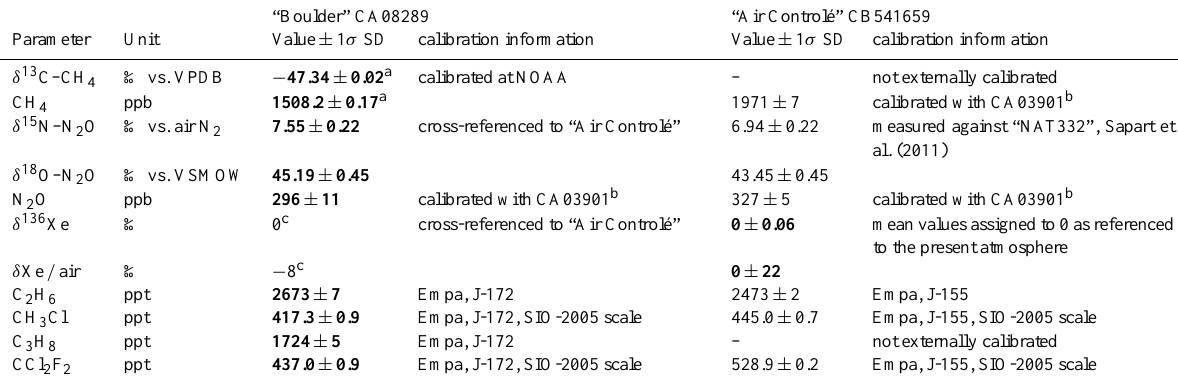
Table 2. List of assigned values for the two reference gas cylinders, their 1 σ SD unless otherwise stated, and details on the external calibra- tions. Values in bold are used to calibrate sample measurements.